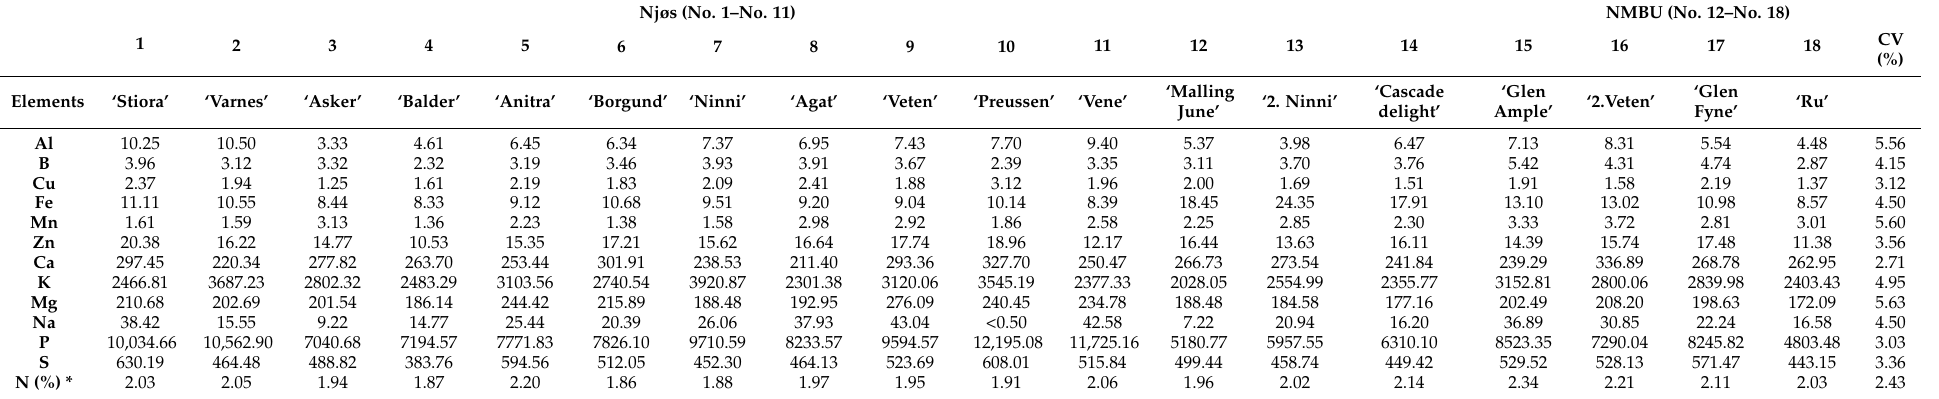
Table 1. The averages of the values of the contents (mg/kg; except N: mass %, i.e., g/100 g) of micronutrients (Al, B, Cu, Fe, Mn, and Zn) and macronutrients (N, P, K Ca, and Mg) in 18 raspberry extract samples during the two-year collection from two Norwegian regions (Njøs No. 1–No. 11 and NMBU No. 12–No. 18) ( p ≤ 0.05). Njøs (No. 1–No. 11) NMBU (No. 12–No.